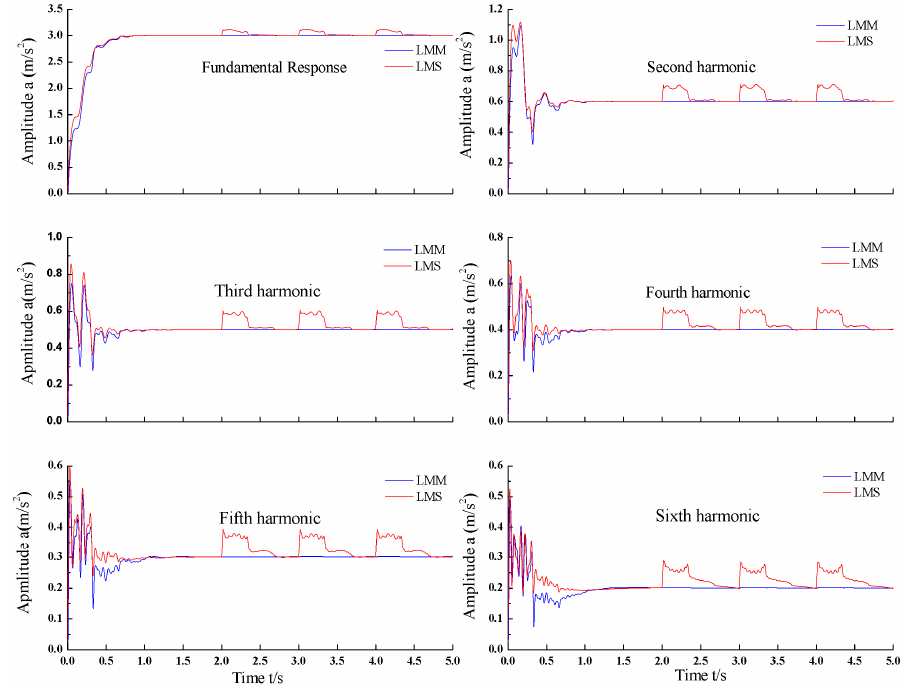
Figure 12. Estimation amplitudes of simulation result (contaminated by impulse noise).